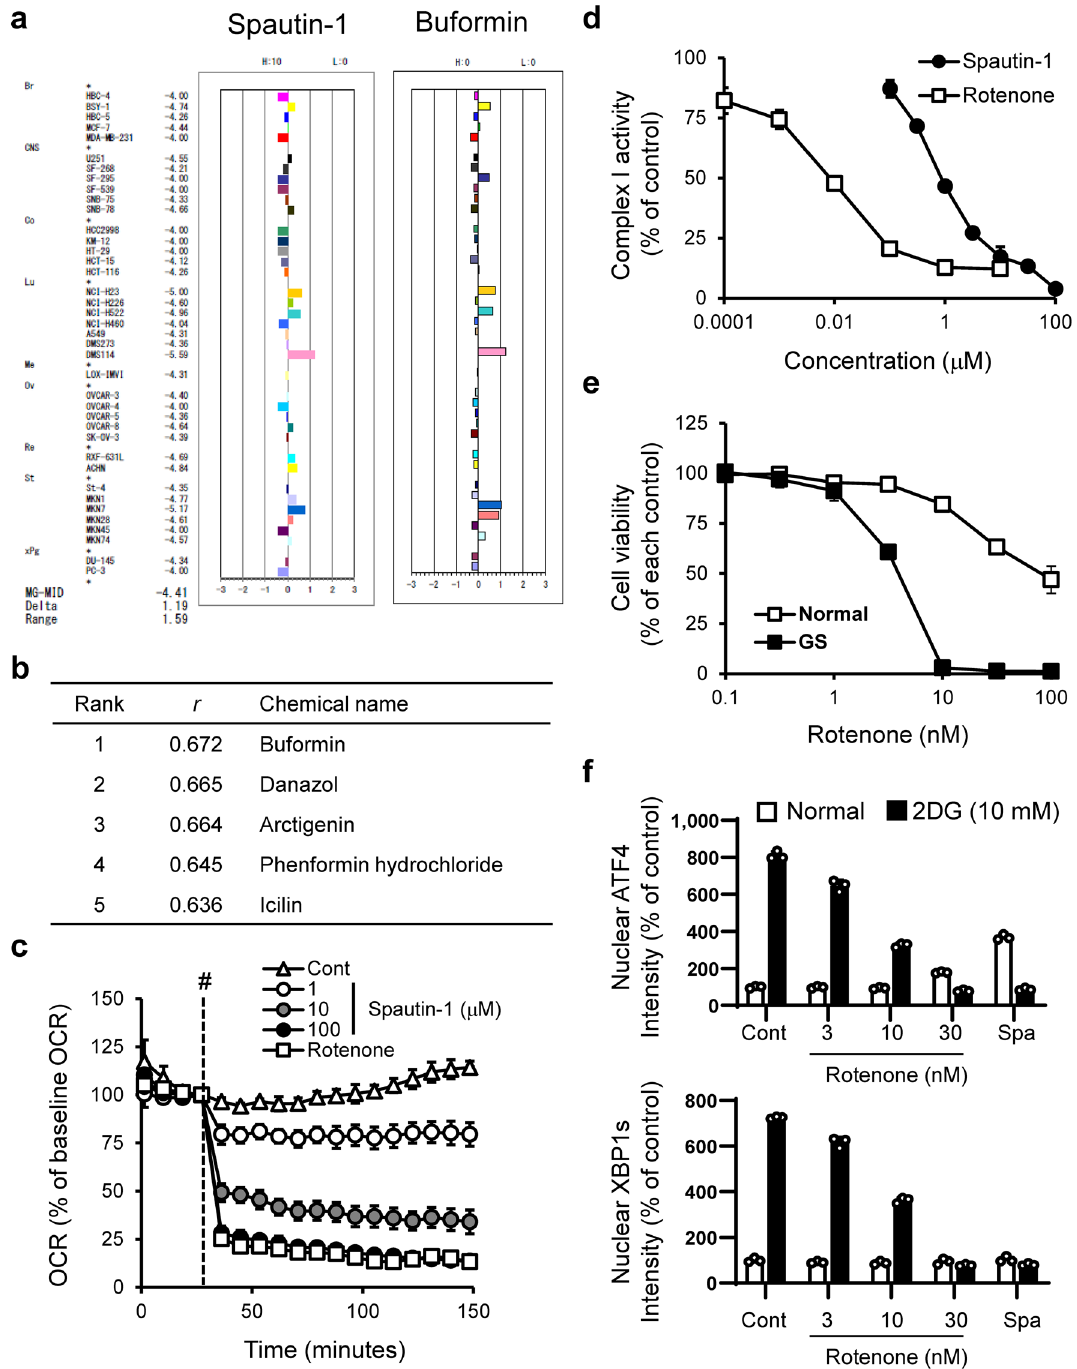
Figure 5. Spautin-1 inhibits mitochondrial complex I activity . ( a ) The mean graph was produced by computer processing of the 50% growth inhibition (GI50) values. The mean graph of spautin-1 (left) is very similar to that of buformin (right). Bottom left: MG-MID, the mean of log GI50 values for 39 cell lines; Delta, the logarithm of difference between the MG-MID and the log GI50 of the most sensitive cell line; range, the logarithm of difference between the log GI50 of the most resistant cell line and the log GI50 of the most sensitive cell line. ( b ) COMPARE analysis between the chemical fingerprints of spautin-1 and anticancer compounds in the JFCR39 cancer cell line panel was performed. ( c ) Oxygen consumption rate (OCR) in HT1080 cells was measured by the XF extracellular flux analyzer. OCR indicates the rate of mitochondrial respiration. Rotenone (100 nM), a mitochondrial complex I inhibitor, was used as a positive control. Data are shown as mean ± SD ( n = 4). ( d ) Effect of spautin-1 on mitochondrial complex I was determined using the MitoTox Complex I OXPHOS Activity kit. Data are shown as mean ± SD ( n = 3). ( e ) Effect of rotenone on cell viability under GS was determined by the CellTiter-Glo luminescent cell viability assay. Data are shown as mean ± SD ( n = 3). ( f ) Effects of rotenone and spautin-1 (10 μM) on induction of nuclear ATF4 and XBP1s under 2DG-stressed conditions were determined using Harmony high-content analysis software. Data are shown as mean ± SD ( n =